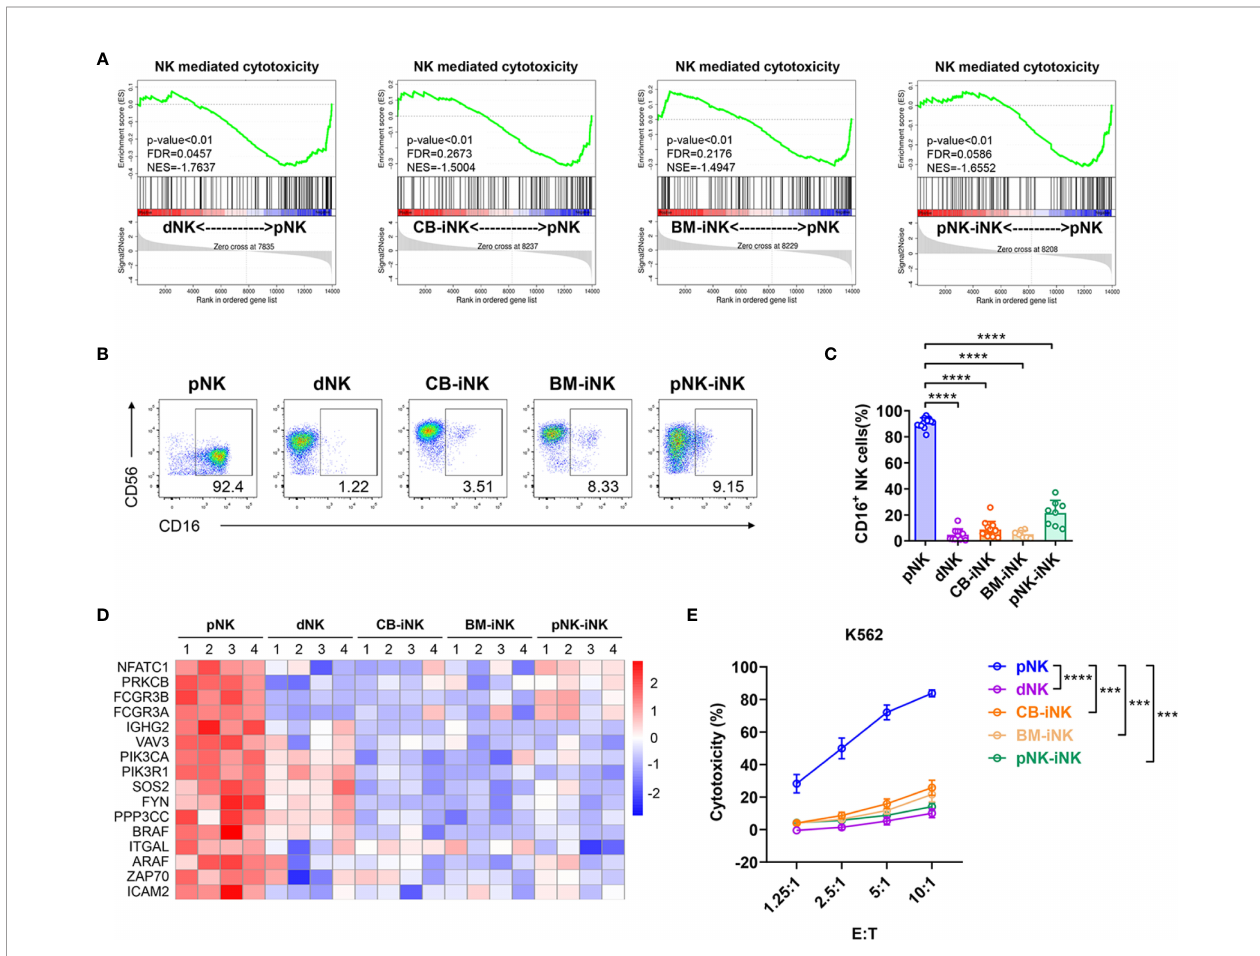
FIGURE 3 | Cytotoxic capability detection of iNK cells. (A) Gene set enrichment analysis (GSEA) revealed an increase in Natural Killer cell-mediated cytotoxicity (enrichment plot: NATURAL KILLER CELL MEDIATED CYTOTOXICITY, HSA04650) in pNK cells compared with dNK cells and three kinds of iNK cells (n=4 per group). (B, C) The percentage of CD16 + NK cells in each group was tested by fl ow cytometry. Representative density plots (B) and statistical calculation of all samples (C) . Data represent means±SD. (D) Some of the NK cells mediated cytotoxicity-related genes were selected for heat map analysis (n=4 per group). (E) The direct cytotoxicity of different NK cells toward K562, as measured by fl ow cytometry. Results are presented as the mean ± SEM. Data were analyzed by one- way ANOVA, and n ≥ 6 in each group (C, E) . ***p < 0.005; ****p <